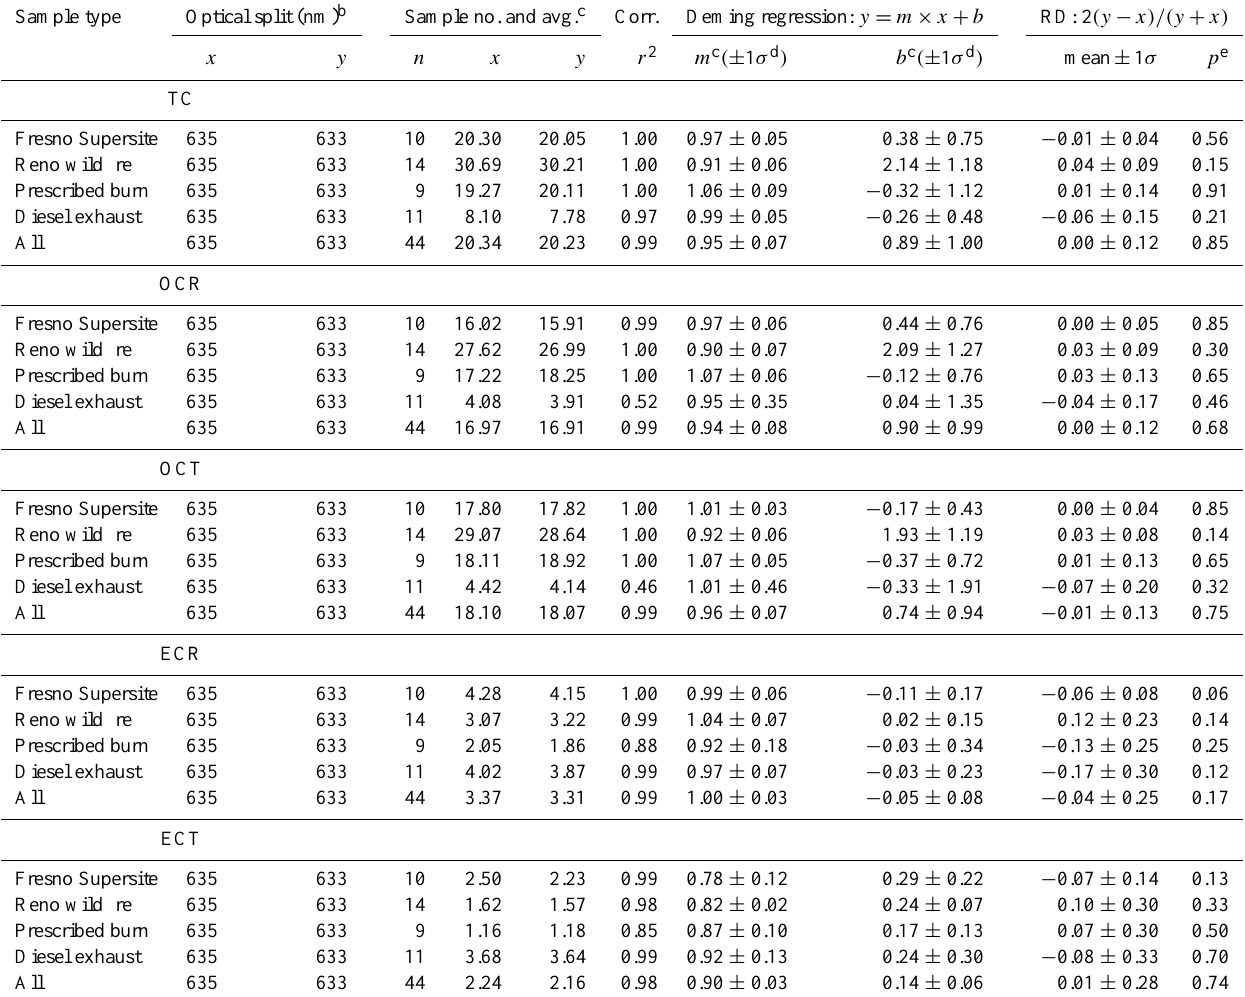
Table 1. Comparison of TC, OCR, OCT, ECR, and ECT between the 633nm (TOA) and 635nm (TSA) optical splits following the IM- PROVE_A protocol.